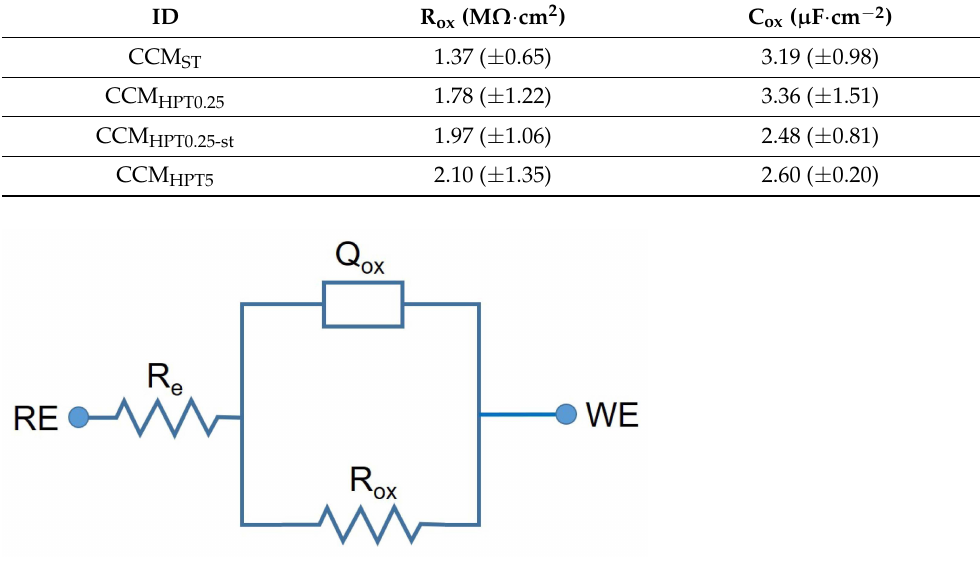
Figure 8. Electrical equivalent circuit (EEC) model for fitting experimental data of CoCrMo